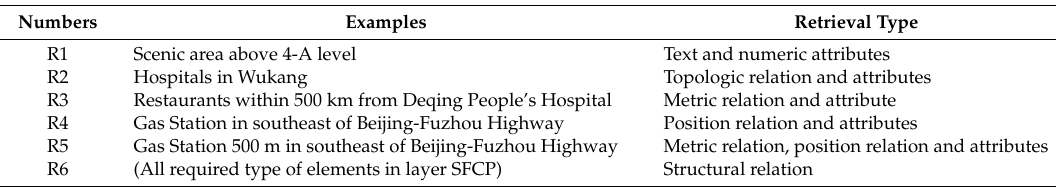
Table 5. Examples of retrieval.